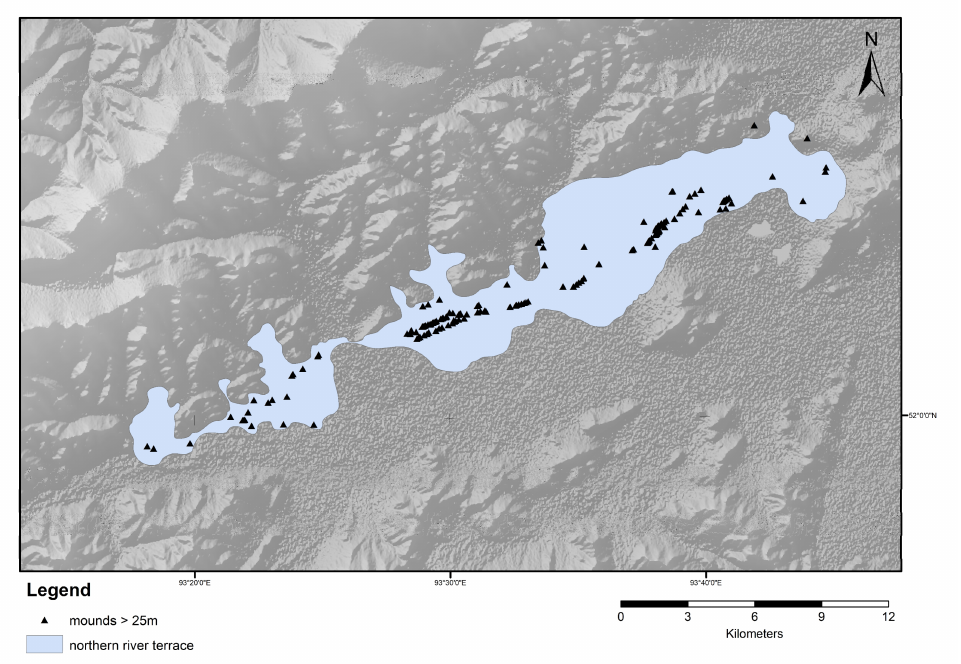
Figure 5. Northern river terrace in the Valley of the Kings with mapped mounds over 25 m in diameter. Several long chains of large burial mounds can be